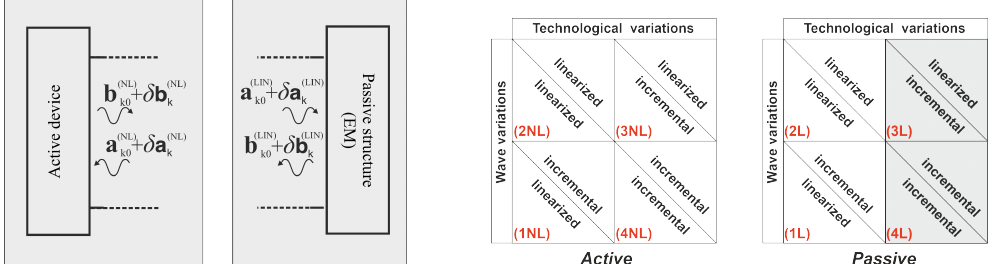
Figure 4. ( Left ): port representation of the effect of technological variability at the block intercon- nection ports. ( Right ): possible model linearization schemes in terms of electrical parameters (port waves) or technological parameters. Cases 3L and 4L do not apply to the passive network